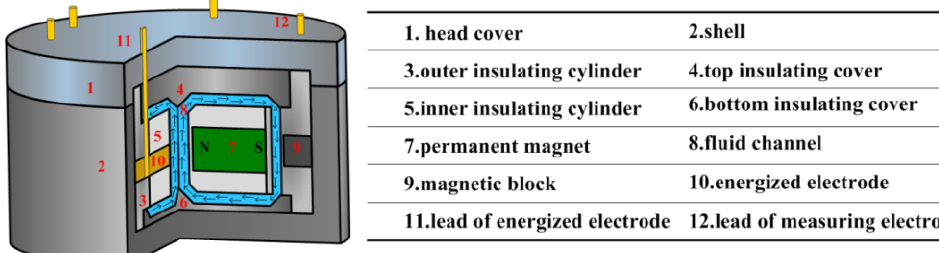
Figure 10. The designed device of DRVG in experiment.